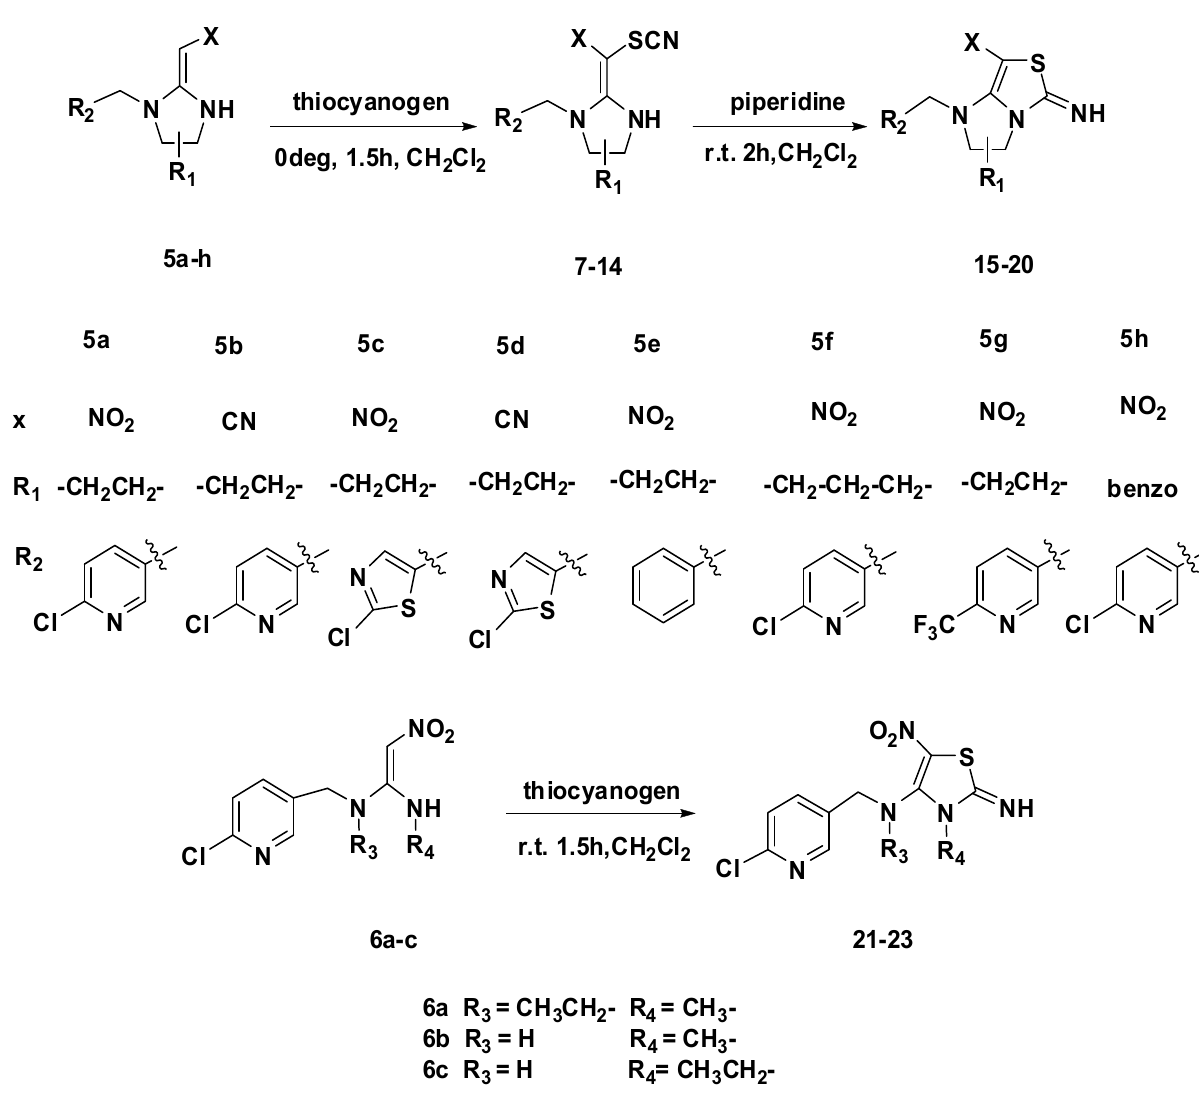
Scheme 1. Synthetic route for the title compounds 7 – 23 .